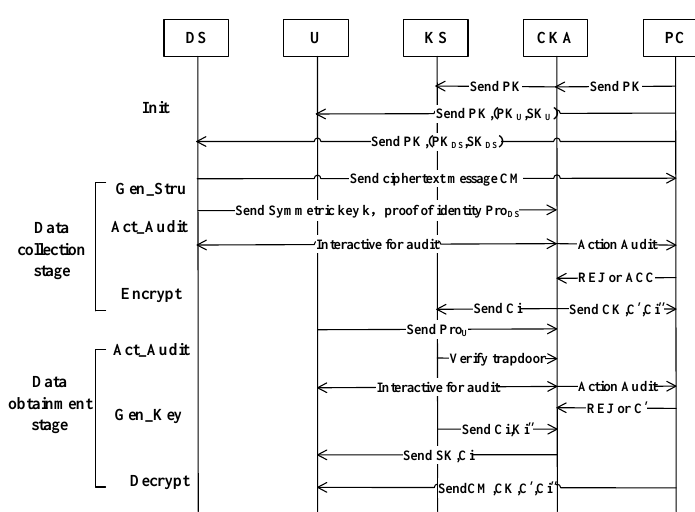
Figure 3. Flow Chart of Access Control.